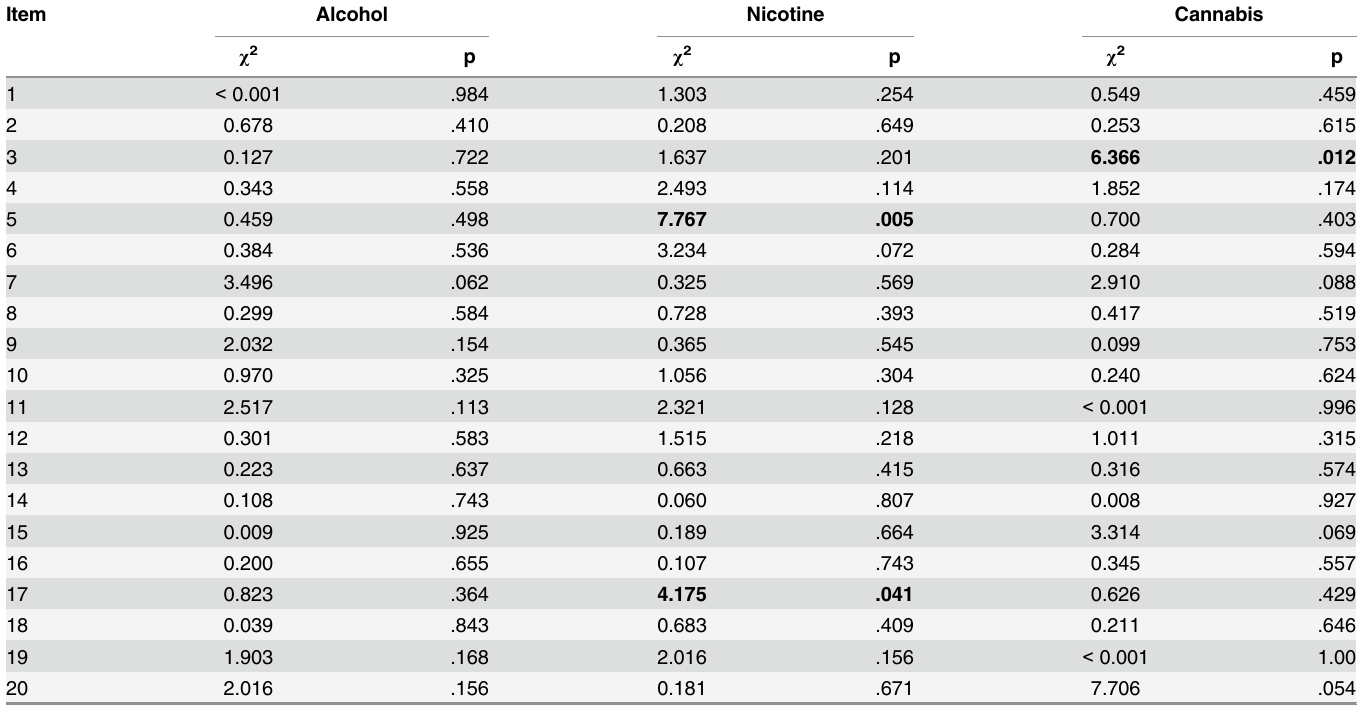
* Bold indicates a signi fi cant difference of means test at α =